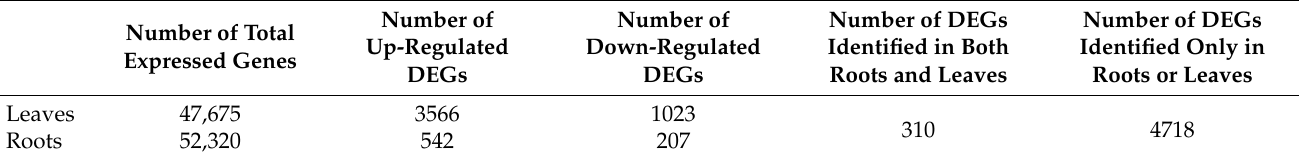
Table 4. A summary of the analysis of the transcriptome in leaves and